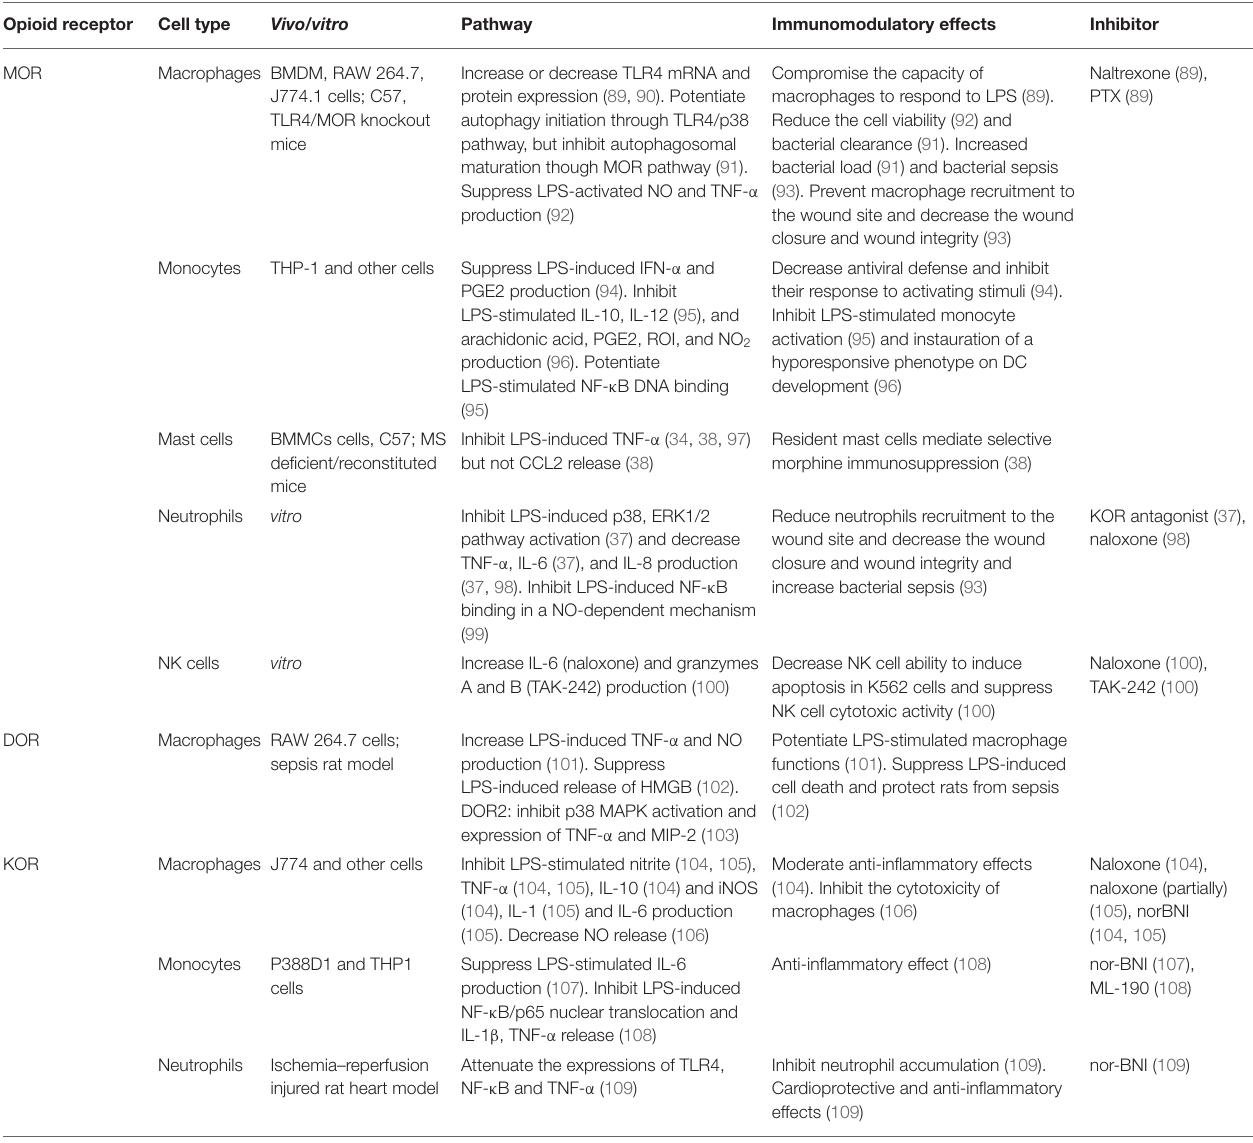
TABLE 1 | Effect of TLR4/opioid receptor pathway crosstalk in peripheral immune cells. Opioid receptor Cell